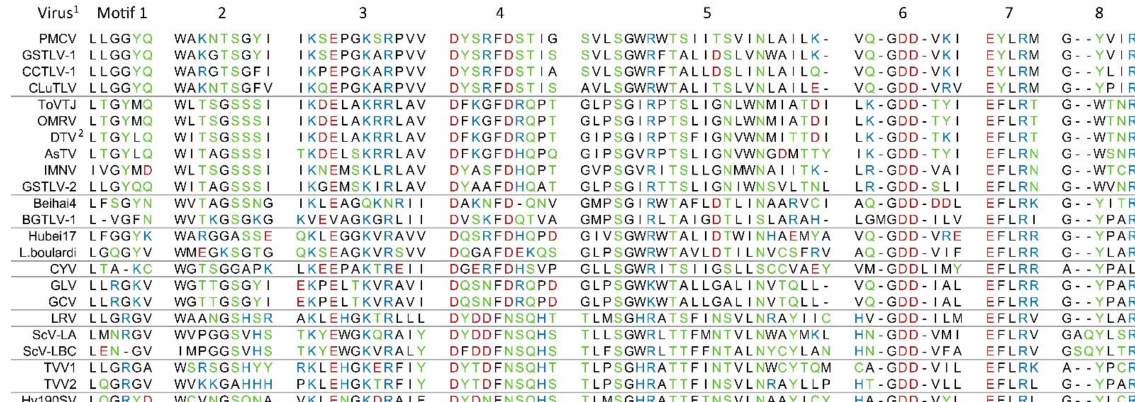
Figure 3. Alignment of the piscine toti-like virus RNA-dependent RNA polymerases (RdRp) motif 1–8 with RdRp motif equivalents of selected members of the family Totiviridae and toti-like viruses. Order and grouping are given according to clusters resulting from phylogenetic analyses (Figure 6b). Amino acids are color coded on polarity; Black non-polar, green polar uncharged, red polar acidic, blue polar basic. Definition of motif length is based on a synergy of previously used by Poimala et al., 2020, Poulos et al., 2006 and original paper describing the motifs of viruses registered in Totiviridae in Bruenn et al., 1993 [14,37,39]. Accession numbers to sequences used can be found in Supplementary Table S1. 1 Virus abbreviations: Piscine myocarditis virus (PMCV), golden shiner toti-like virus 1 (GSTLV-1), common carp toti-like virus 1 (CCTLV-1), Cyclopterus lumpus toti-like virus (CLuTLV), Tianjin totivirus (ToVTJ), Omono river virus (OMRV), drosophila totivirus (DTV), Armigeres subalbatus totivirus (AsTV), infectious myonecrosis virus (IMNV), golden shiner toti-like virus 2 (GSTLV-2), Beihai toti-like virus 4 (Beihai4), bluegill toti-like virus 1 (BGTLV-1), Hubei toti-like virus 17 (Hubei17), Leptopilina boulardi toti-like virus (L. boulardi), Camponotus yamaokai virus (CYV), Giardia lamblia virus (GLV), Giardia canis virus (GCV), Leishmania RNA virus (LRV), Saccharomyces cerevisiae virus L-A (ScV-LA), Saccharomyces cerevisiae virus L-BC (La) (ScV-LBC), Trichomonas vaginalis virus 1 (TVV1), Trichomonas vaginalis virus 2 (TVV2), and Helminthosporium victoriae 190S virus (Hv190SV). 2 Motif 1 is found outside defined ORF2 in part included between ORF1 and ORF2 if expressed as a fused